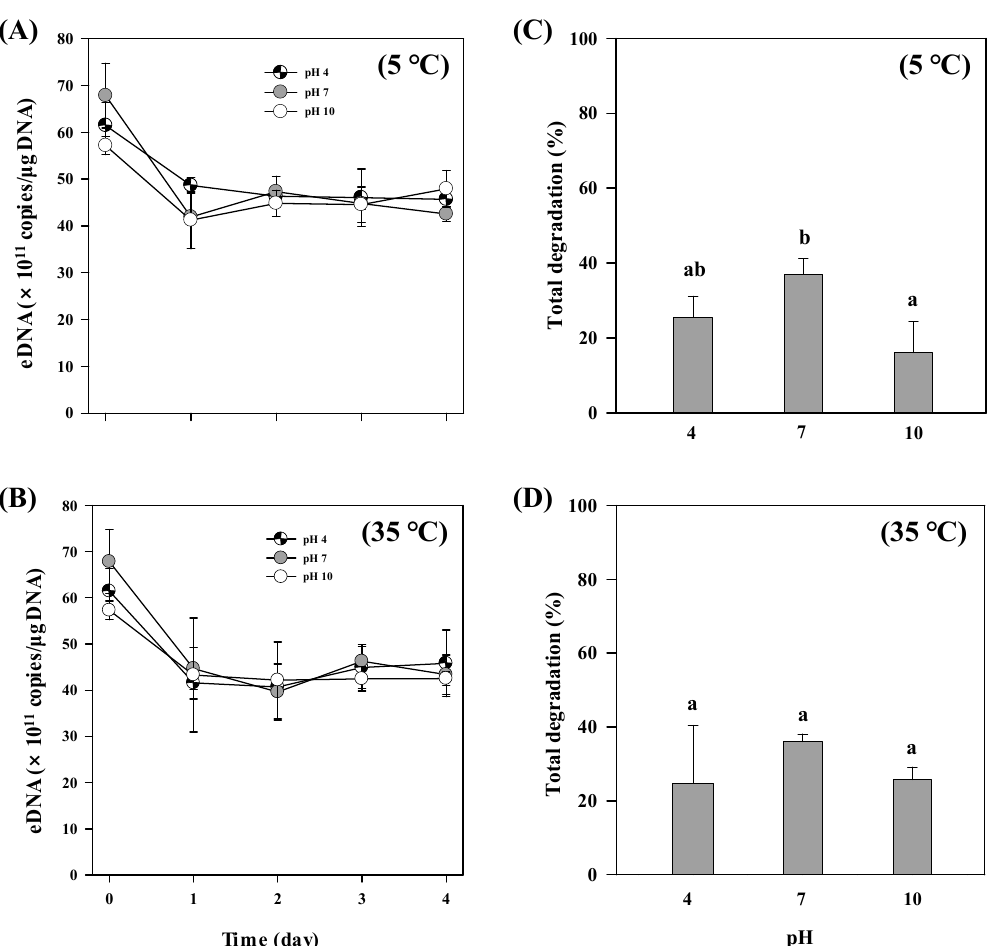
Figure 4. ExDNA concentration in samples exposed to different pH levels combined and temperatures. ( A , B ) Changes in exDNA concentration detected under different pH levels at different temperatures (5 °C and 35 °C). ( C , D ) Total exDNA degradation (%) at the end of the experiments (4 days). Different letters indicate statistically significant differences defined by p < 0.05 between treatments. Error bars represent the standard deviations among replicates within treatments.